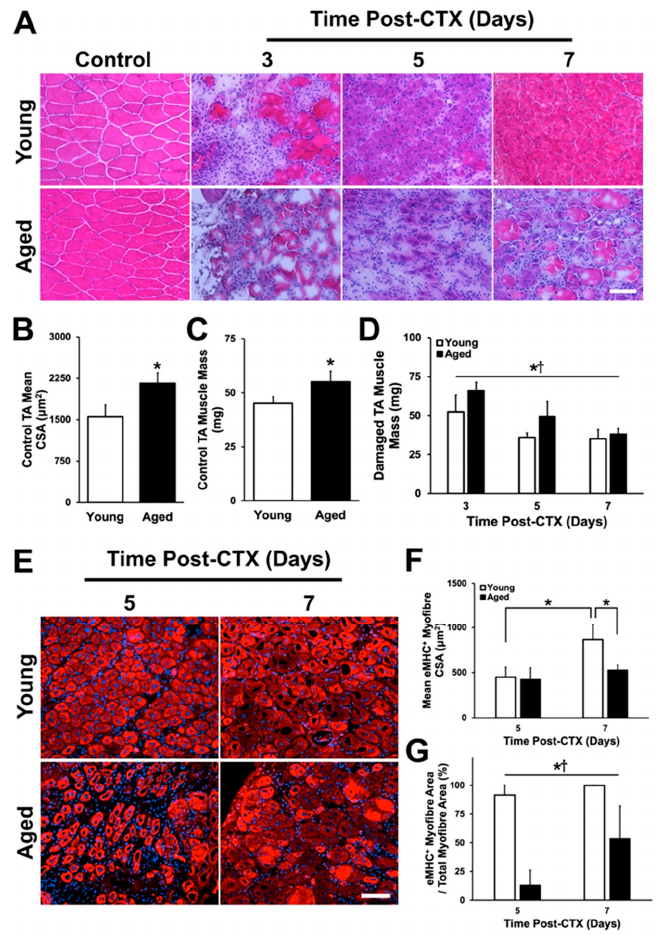
Figure 2. Regenerative capacity of aged skeletal muscle is impaired. ( A ) hematoxylin and eosin (H&E) cryosections of the TA muscle throughout the regeneration time course (3–7 days). Control (undamaged) TA ( B ) mean cross-sectional area ( p = 0.003) and ( C ) muscle mass were significantly greater in the aged group ( p < 0.001). * denotes a significant di ff erence detected by two-tailed t -test. ( D ) Damaged TA muscle mass was di ff erent between young and aged groups and across recovery time points. * denotes a significant main e ff ect of age ( p = 0.001). † denotes a significant main e ff ect of recovery time point following damage ( p < 0.001). ( E ) Regenerating myofibers were identified via embryonic myosin heavy chain (eMHC; red) and 4,6-diamidino-2-phenylindole (DAPI; blue) at five and seven days following damage. ( F ) A significant interaction between age and recovery time points was observed ( p = 0.02). Regenerating myofiber cross-sectional area was found to increase from five to seven days in young mice (simple main e ff ects post-hoc analysis: p < 0.001), and there was a significant di ff erence at seven days between young and aged muscle (simple main e ff ects post-hoc analysis: p = 0.001). ( G ) Relative regenerating myofiber area was significantly greater in young muscle compared to aged muscle at five and seven days following damage. * denotes a significant main e ff ect of age ( p < 0.001). † denotes a significant main e ff ect of recovery time point following damage ( p = 0.013). n = 4–5 per group. Data presented are means ± standard deviation. Scale bar represents 50 µ